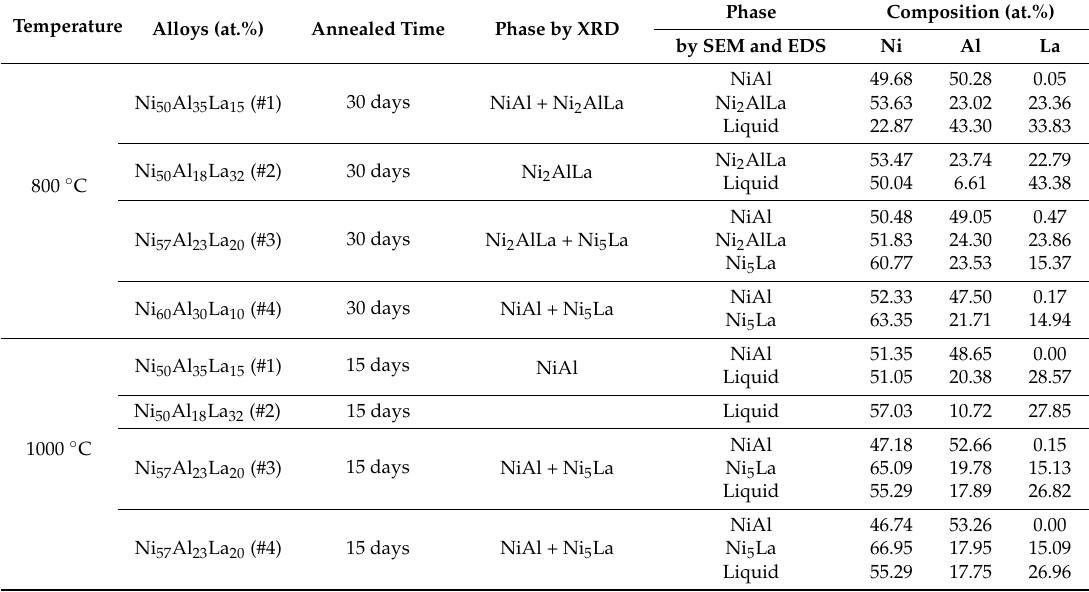
Phase Composition